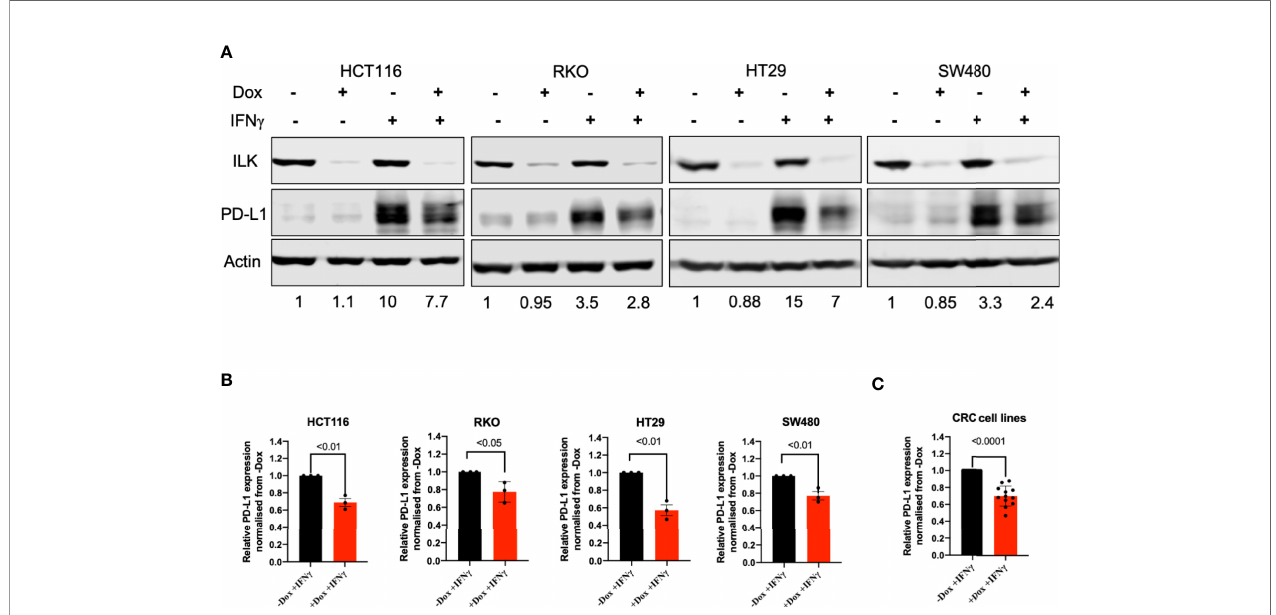
FIGURE 10 | ILK KD reduced IFN g -induced PD-L1 expression in the CRC cell lines. (A) Western blot showed PD-L1 induction by IFN g (50 ng) for 24 hr in HCT116, RKO, HT29 and SW480 CRC cells. Actin was used as an internal control. The protein quantitation was determined by relative ratio to actin. The relative PD-L1 expression is normalized to the -Dox unstimulated protein. (B) The quantitation of PD-L1 expression in CRC cell lines. (C) The quantitation of PD-L1 protein expression in the different CRC cell lines combined. The relative PD-L1 expression is normalized to the -Dox protein. Error bars are represented as mean ± SEM (n = 3). P -value was analyzed with an unpaired t-test. The signi fi cant P -value is <